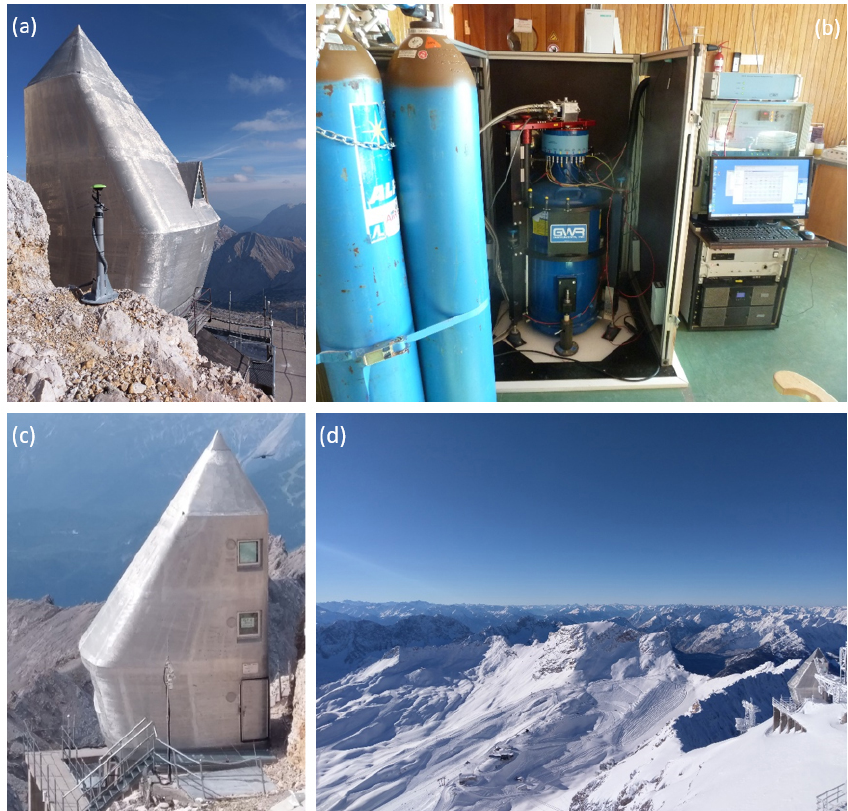
Figure 2. (a) The Zugspitze Geodynamic Observatory Germany (ZUGOG) with Global Navigation Satellite Systems (GNSS) station in front. (b) OSG 052 installed on the ground floor at ZUGOG. (c) ZUGOG with snow height sensors and snow scale in front. (d) ZUGOG with a winter view of a part of the alpine research catchment Zugspitze including the northern and southern Schneeferner glaciers.